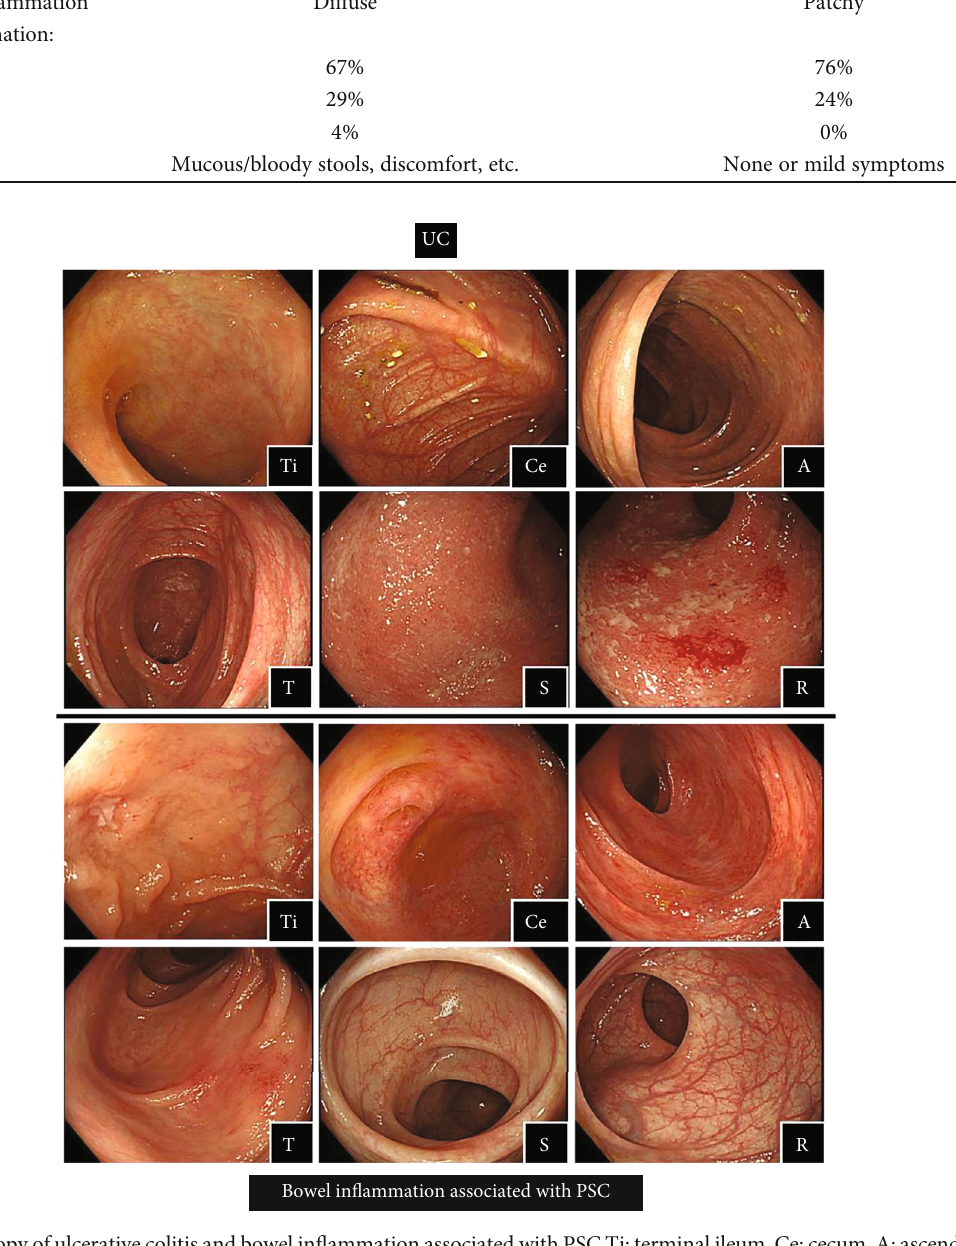
Figure 1: Colonoscopy of ulcerative colitis and bowel in fl ammation associated with PSC Ti: terminal ileum, Ce: cecum, A: ascending colon, T: transverse colon, S: sigmoid colon, and R: